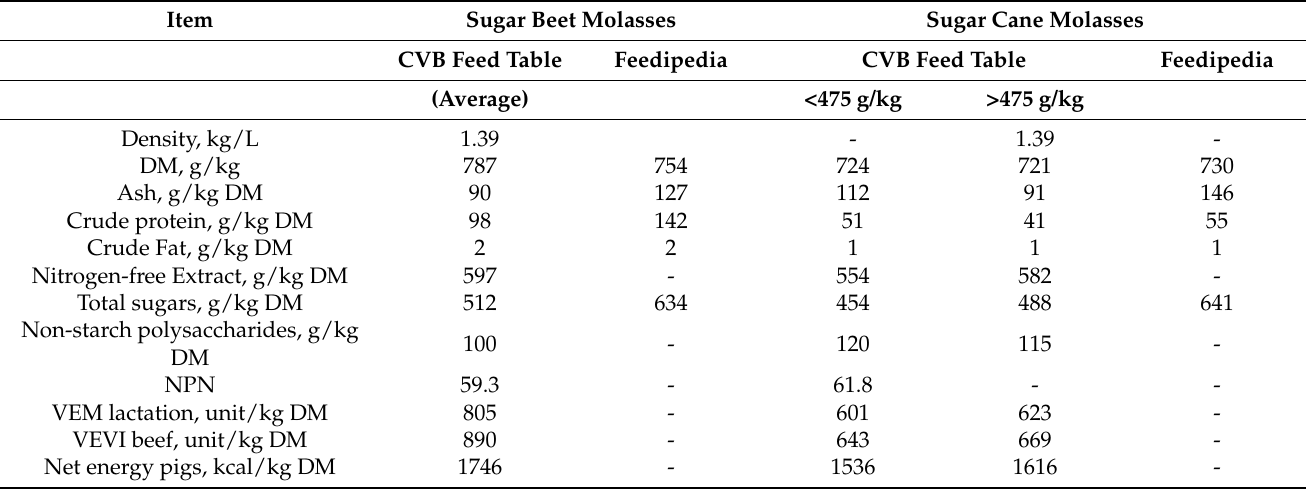
Table 1. Composition and nutritive value per kg of sugar beet and sugar cane molasses (modified from the CVB Feed Table 2019. Chemical composition and nutritional values of feedstuffs. www.cvbdiervoeding.nl; and from https://www.